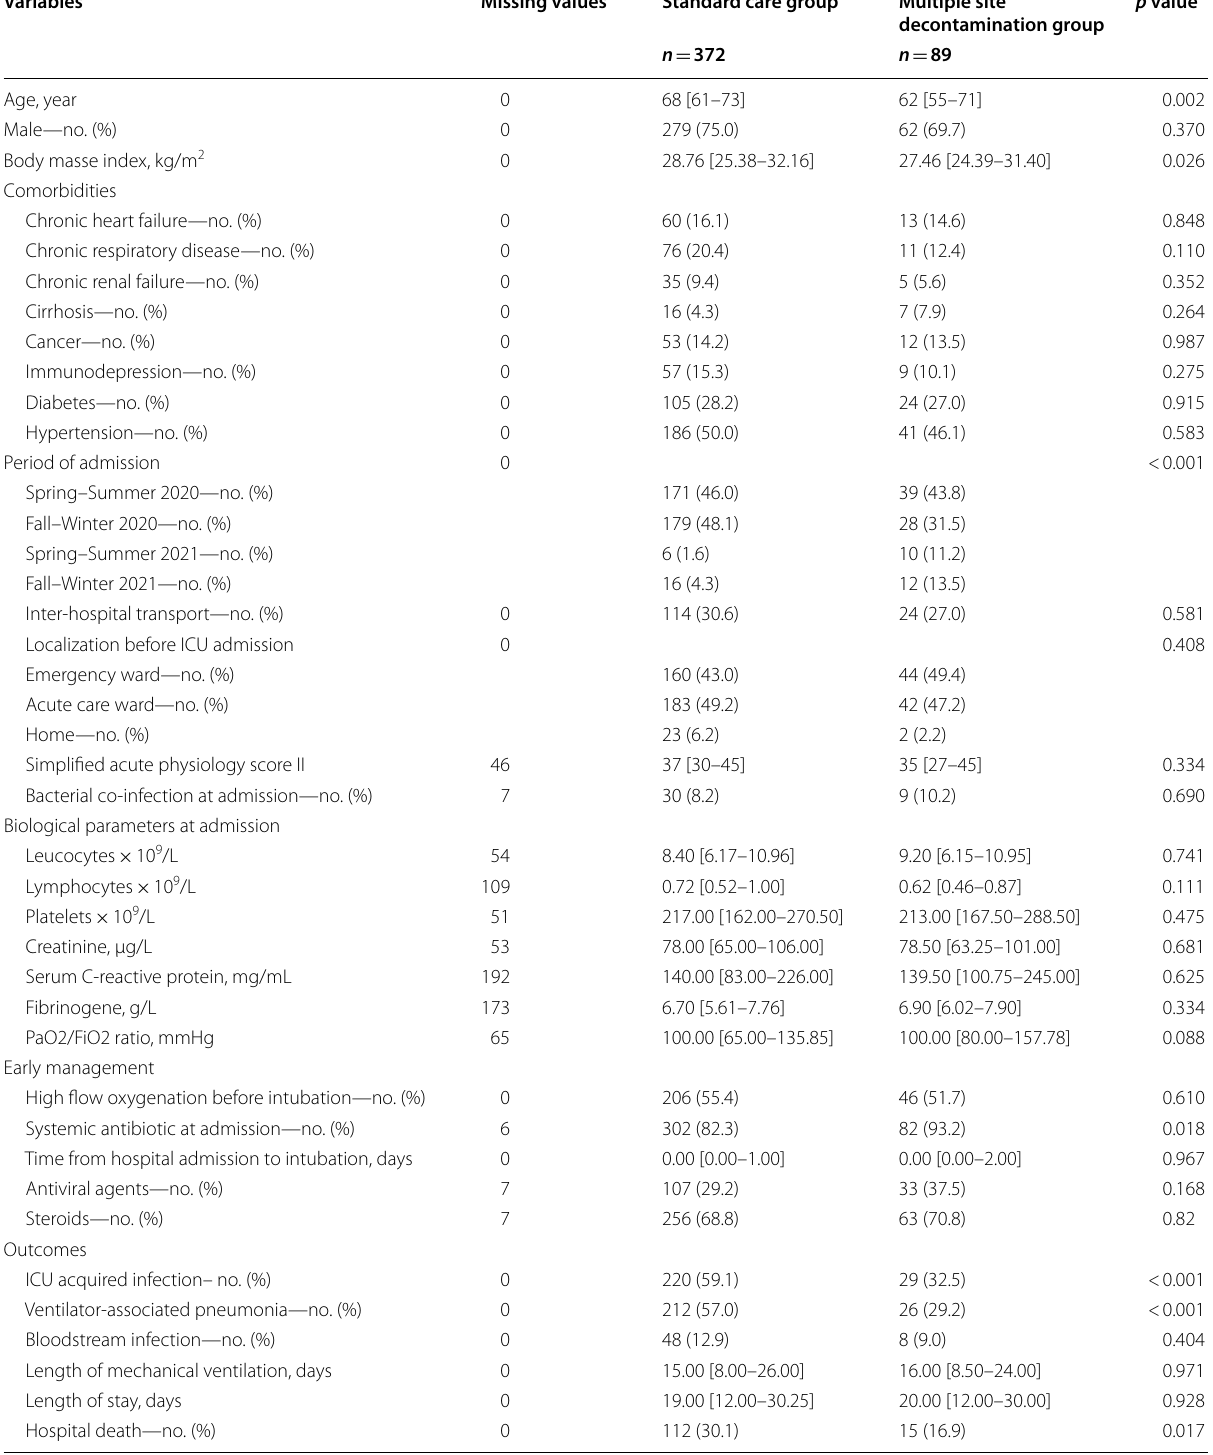
Table 1 Baseline characteristics and outcomes of study patients Variables Missing values Standard care group Multiple site